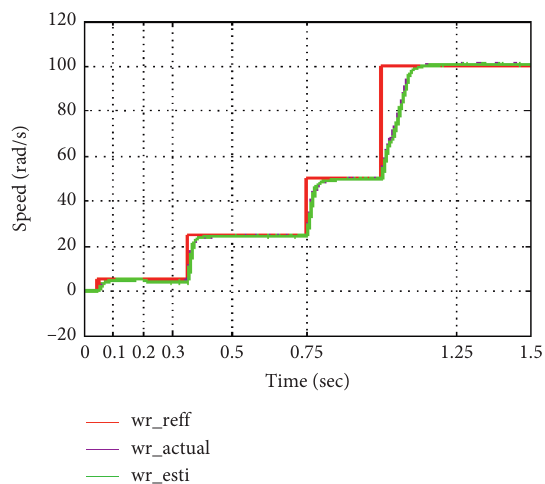
Figure 21: Speed response of staircase tracking waveform including the low speed region.